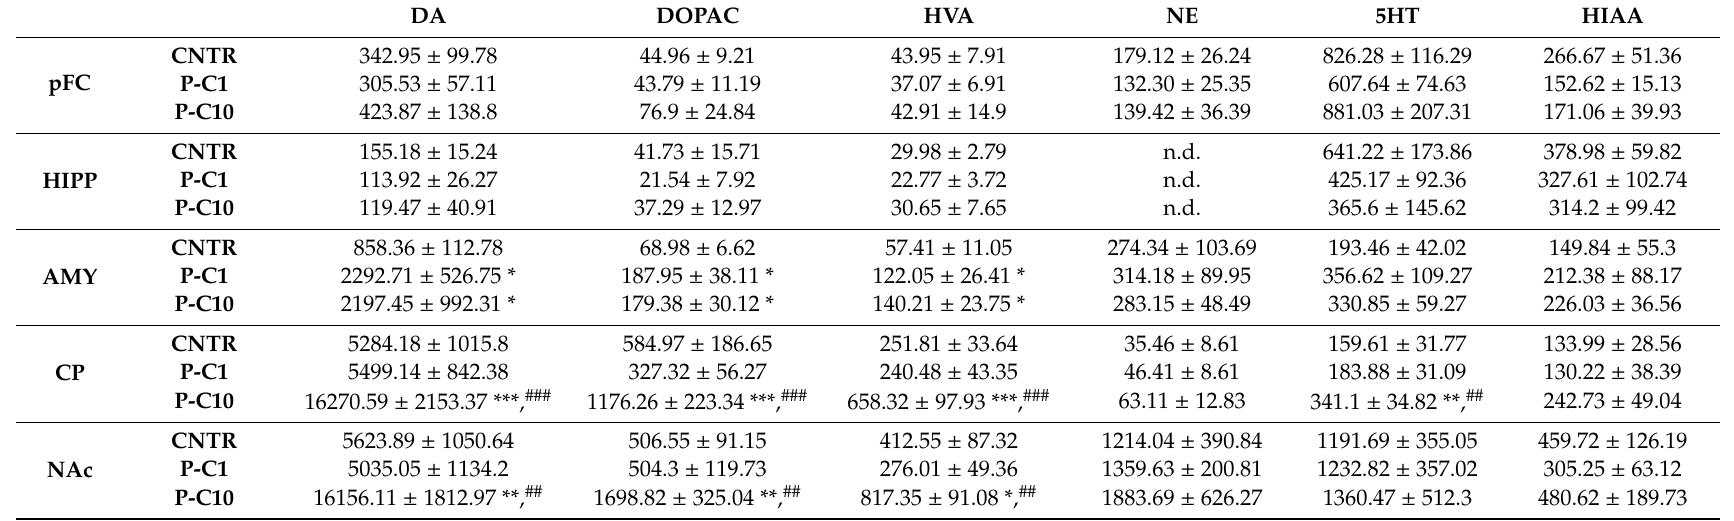
Table 1. Neurochemical analysis of monoamine and metabolite levels (ng / g wet weight) assessed in medial prefrontal cortex, hippocampus, amygdala, caudate putamen and nucleus